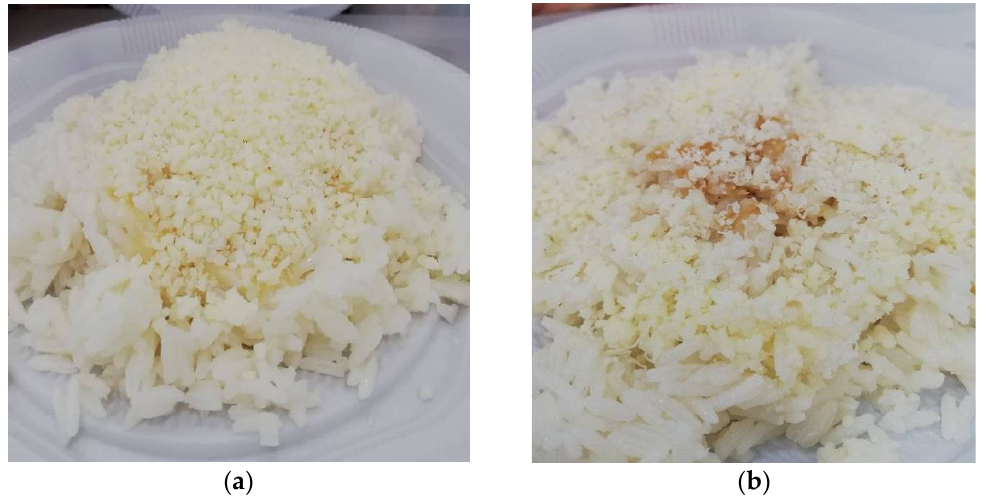
Figure 1. ( a ) Control meal; ( b ) functional meal, before consumption.